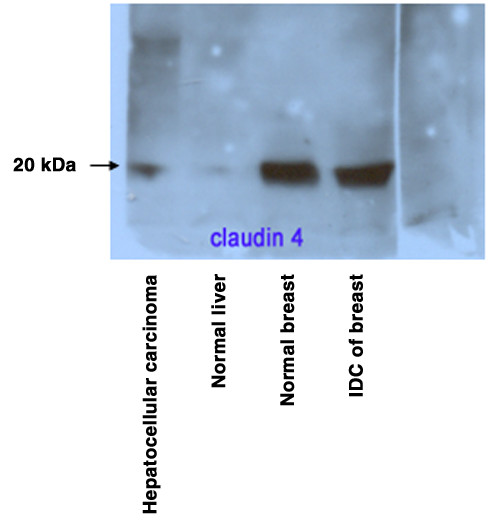
The monospecificity of claudin (CLDN)4 antibody using Western blot analysis. CLDN4 protein expression in invasive breast carcinoma, surrounding normal breast and human liver. Western blot analysis was performed on equal amounts of protein from total cell lysates using CLDN4 monoclonal antibody. A single band was shown at approximately 22 kDa for CLDN4. IDC, invasive ductal carcinoma.